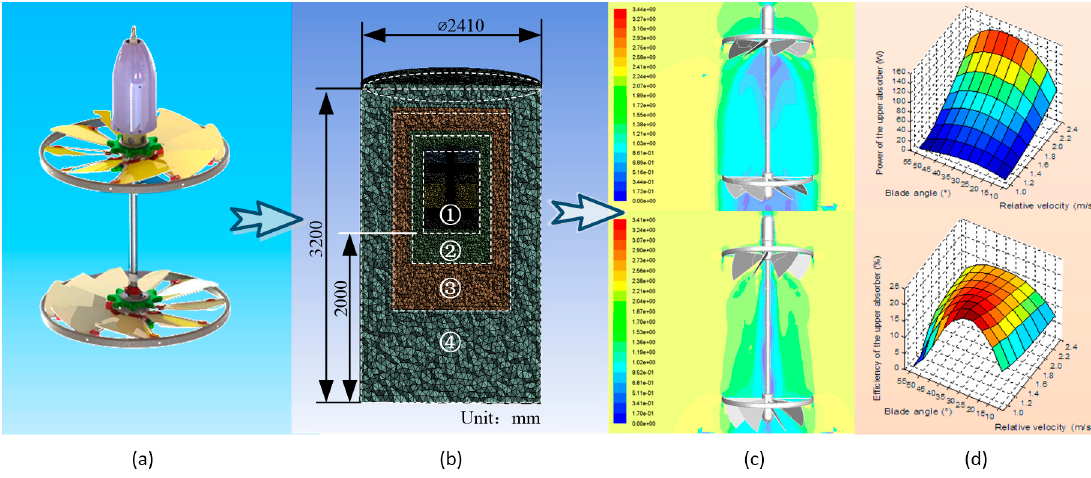
Figure 4. Design concept and mechanical structure: ( a ) simplified numerical model; ( b ) vertical section of the mesh model; ( c ) velocity contours of the vertical section of the absorber with different blade angles; ( d ) combined effect of blade angle and relative velocity on the performance of the upper absorber.